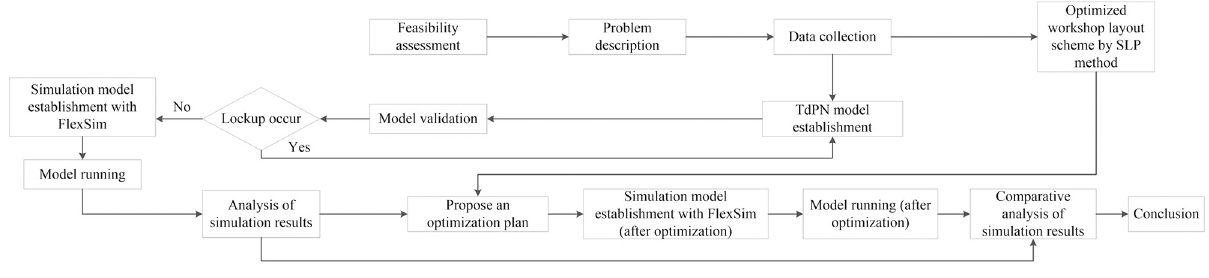
Fig 10. Design diagram of simulation